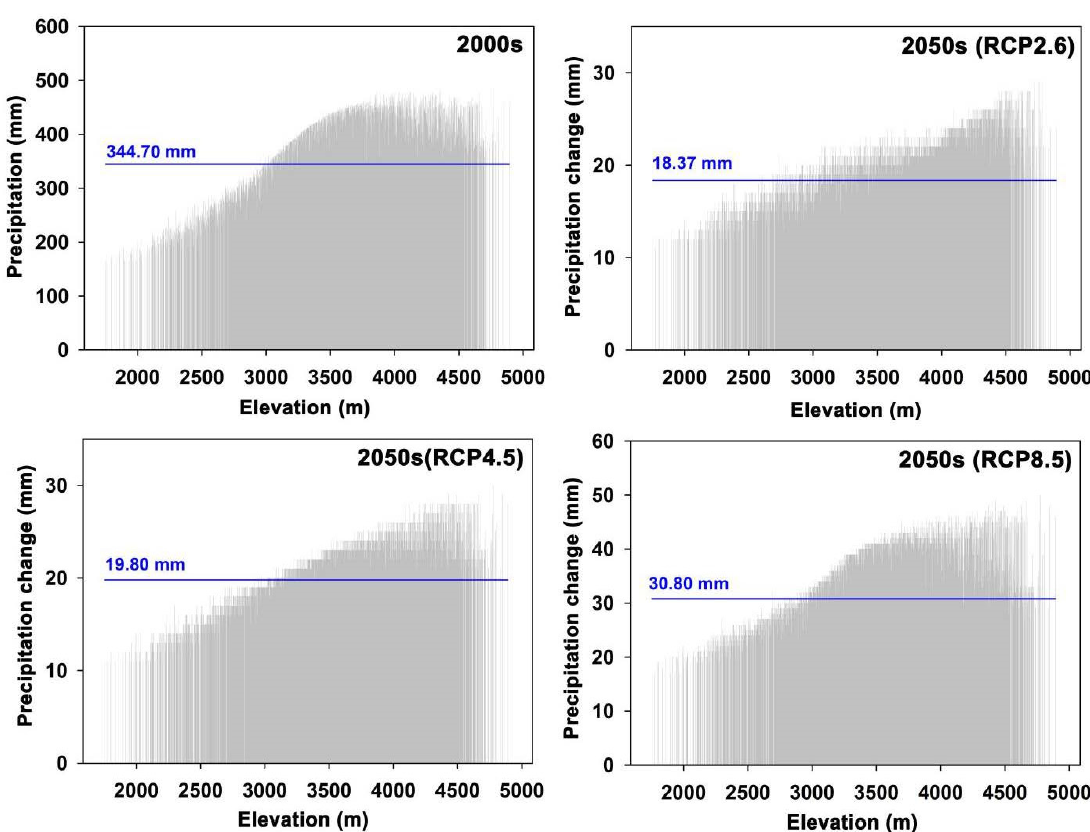
Figure 4. Variation of mean annual temperature in the 2000s, and temperature change (difference for temperature between the 2050s and the 2000s) under the RCP2.6, RCP4.5, and RCP8.5 scenarios, along the elevation gradient for each 1 km × 1 km pixel. Note: The blue lines indicate the area-weighted averages of temperature or temperature difference between the 2050s and the 2000s for the whole study area. Each vertical gray line represents a 1 km × 1 km pixel over the study area, and the height of the gray line indicates the temperature value at that pixel. Most parts of the study area were located in regions with elevations ranging from 3000 to 3800 m, and thus, gray lines are much denser in mid-elevation zones, while sparser in high- and low-elevation zones.